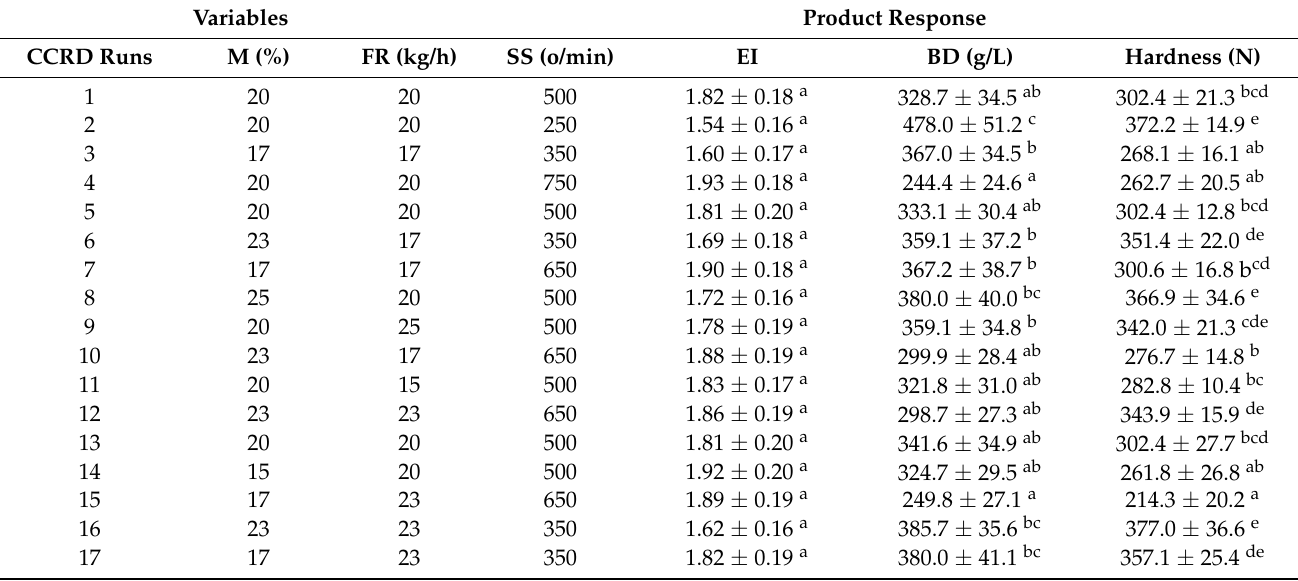
Table 1. Experimental EI, BD and hardness values of snack according to the adopted central composite rotatable design (CCRD) experimental